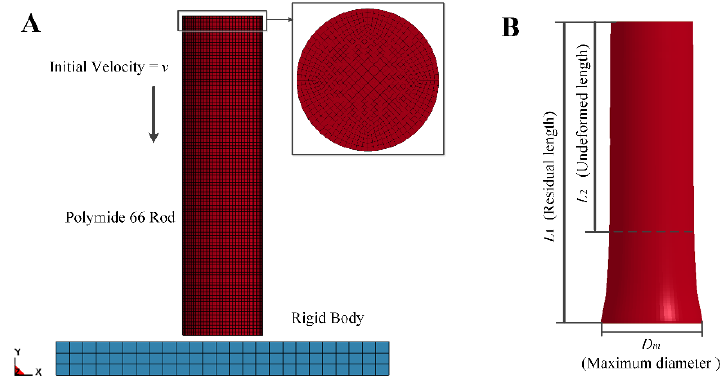
Figure 7. ( A ) A 3-D simulation model of Taylor impact test; ( B ) Three key dimensions of post-test bar.